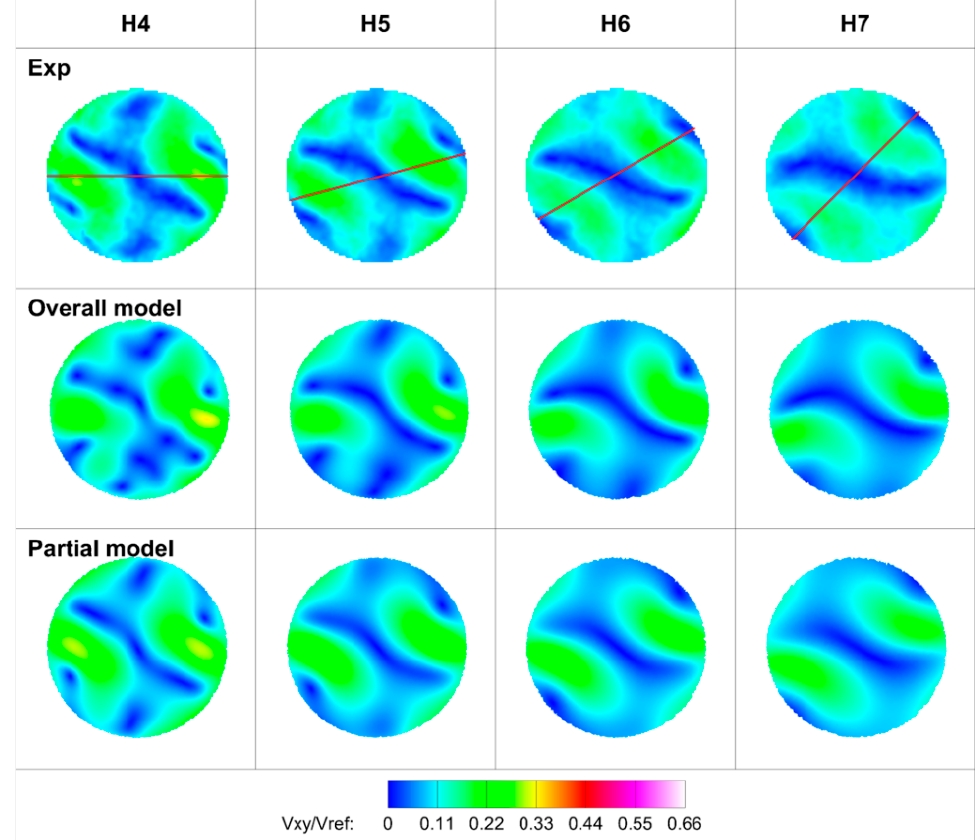
Figure 11. Comparison of the numerical simulation and experiment results.